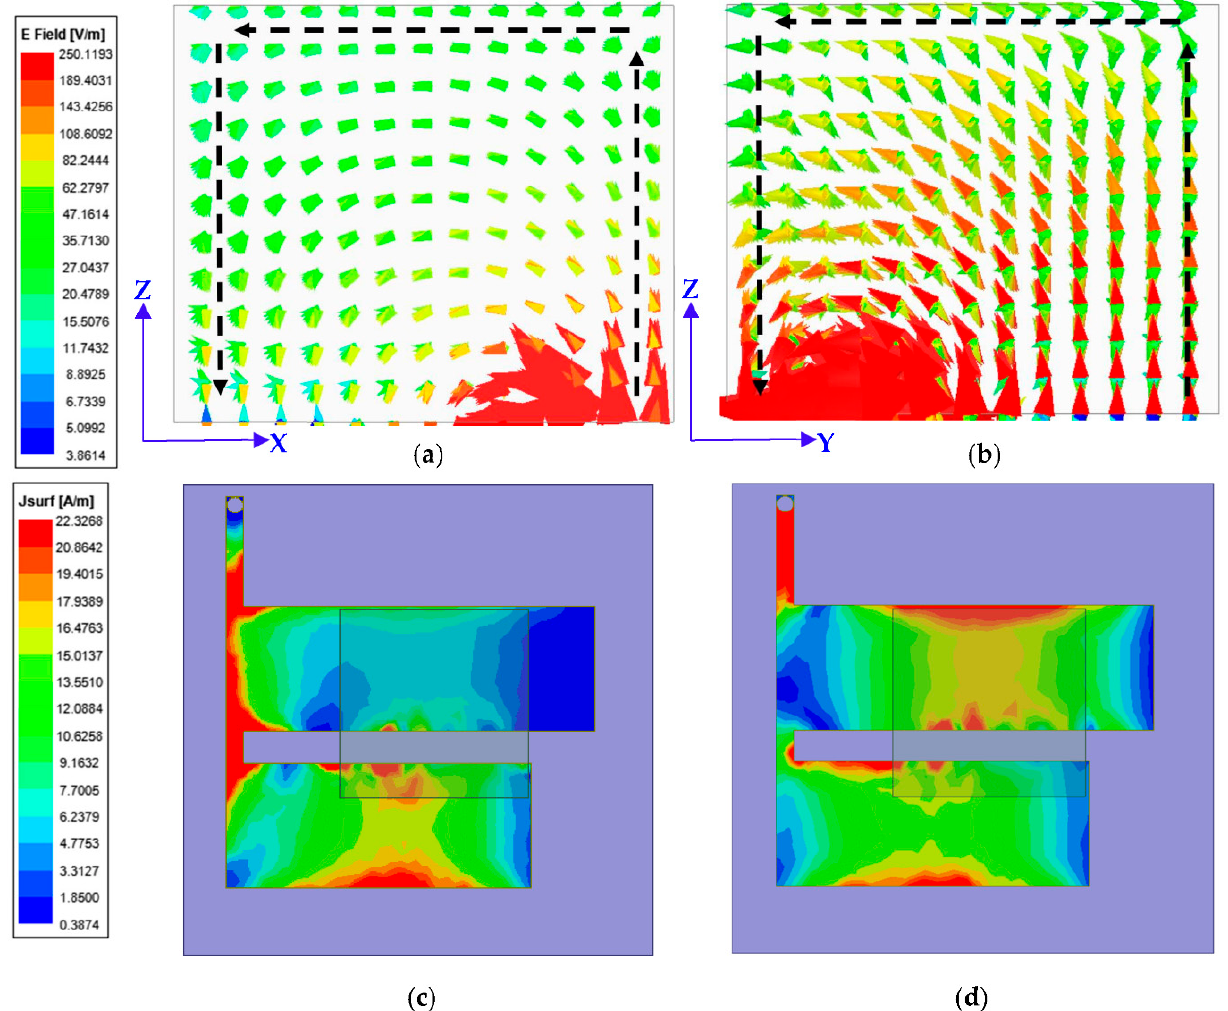
Figure 3. E-Field within DR; ( a ) TE 01 δ at 3.3 GHz; ( b ) TE 10 δ at 3.96 GHz; ( c ) surface current on resonator at 3.3 GHz; and ( d ) surface current at 3.96 GHz.